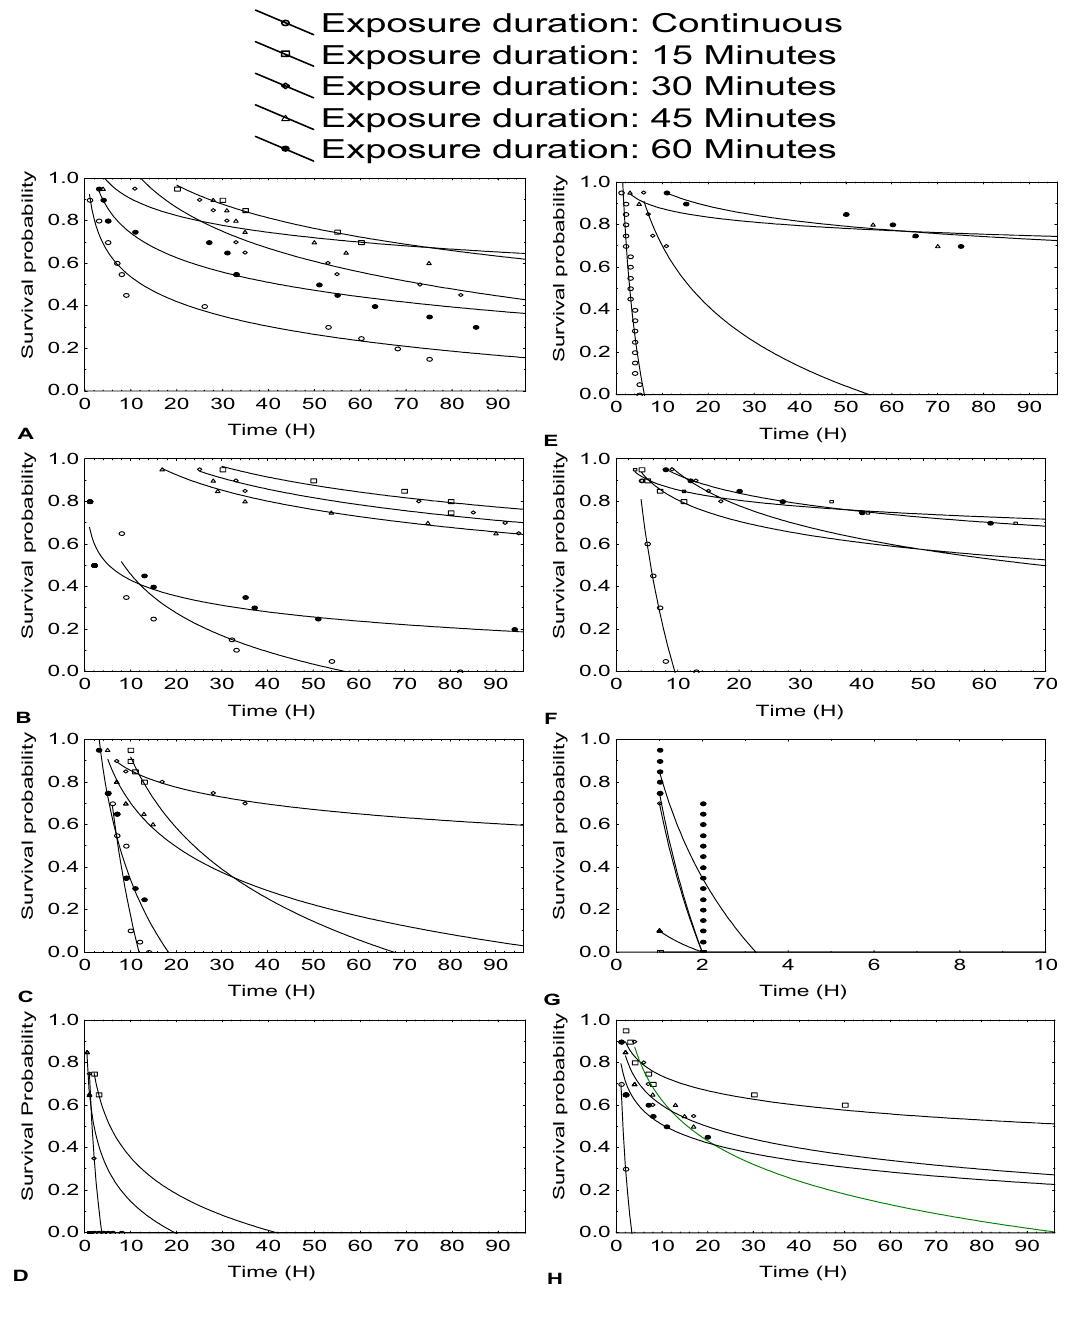
Figure 1. Survival probability-Time curve of catfish exposed to atrazine ( A ), mancozeb ( B ), chlorpyrifos ( C ), lambda cyhalothrin ( D ), and Nile tilapia exposed to atrazine ( E ), mancozeb ( F ), chlorpyrifos ( G ) and lambda cyhalothrin ( H ). Unit of pesticide concentration is mg/L, except lambda cyhalothrin which is µg/L.